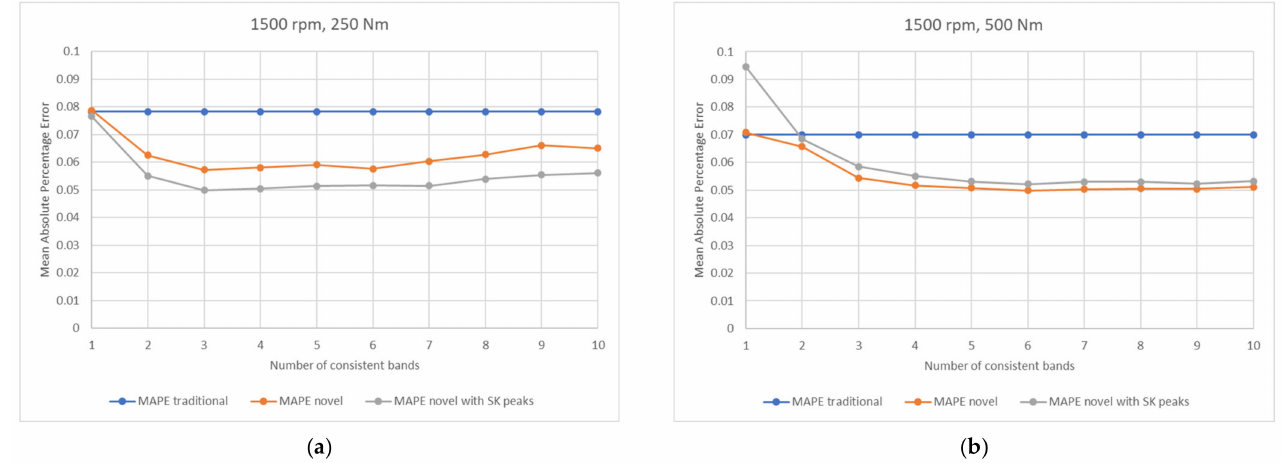
Figure 14. Results comparing operating conditions, techniques, and number of dimensions to use during machine learning. All charts have been scaled identically to aid in comparisons; ( a ) low torque results; ( b ) high torque